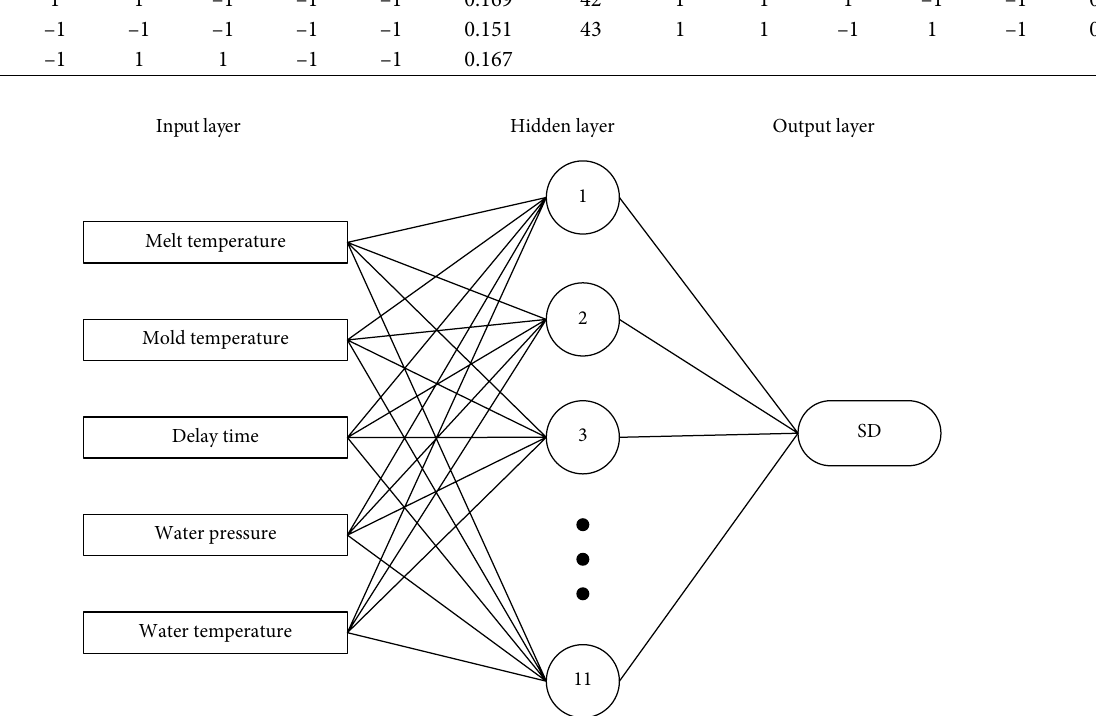
Figure 3: Topology of artificial neural